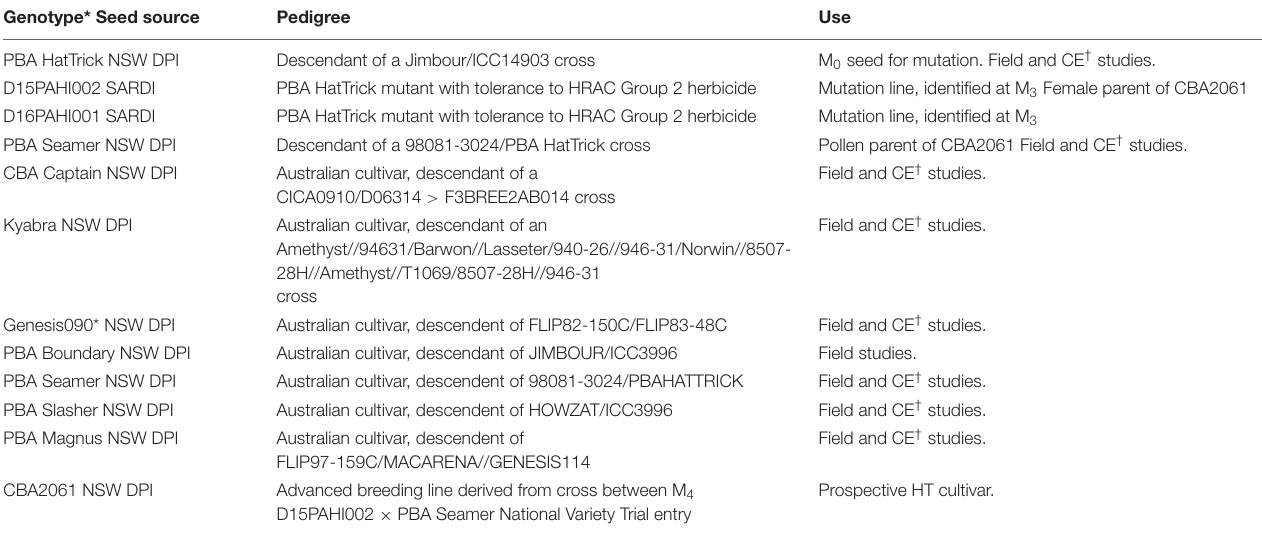
TABLE 2 | Genotypes, pedigree, and use of